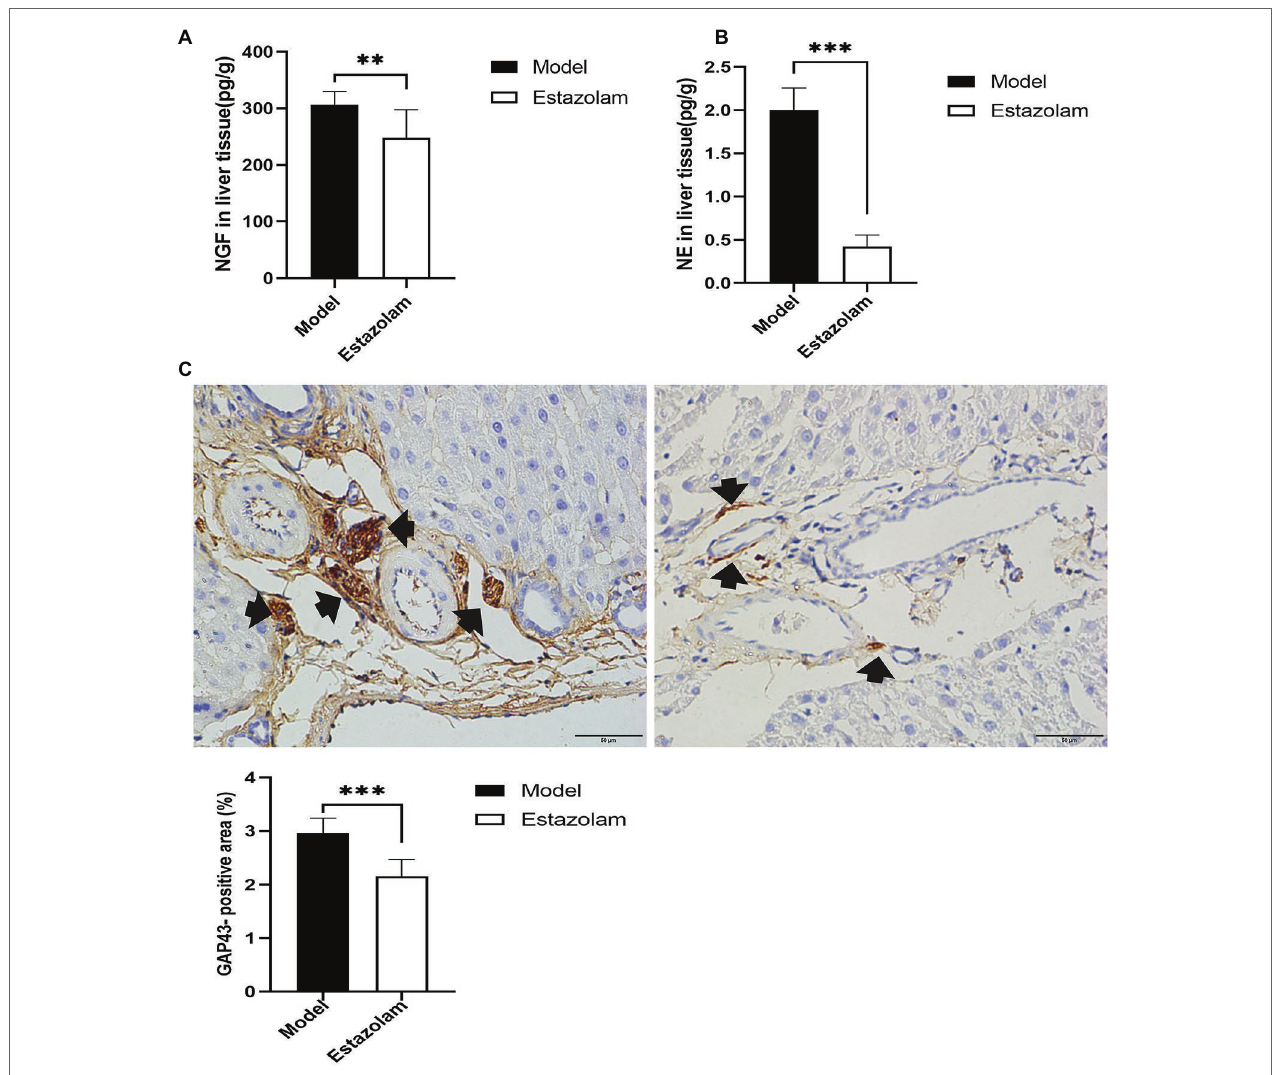
FIGURE 7 | Sympathetic innervation in liver was evaluated. (A) The NGF level was tested in liver tissues. (B) NE in liver tissues was detected by HP-LC-MS/MS. (C) GAP43 staining was observed in the liver as a qualitative metric of neural growth by immunohistochemistry (scale bar: 50 μ m). The results were obtained from two independent experiments and are expressed as the mean ± SD, n = 8 per group, ** p < 0.01 and *** p < 0.001. NE,